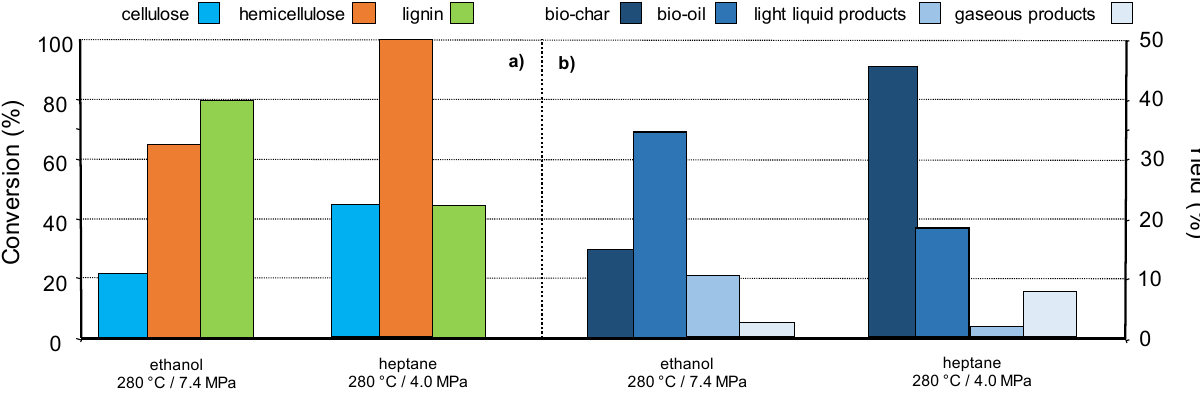
Figure 8. Pine wood ( a ) conversion and ( b ) products yields, in supercritical ethanol or supercritical heptane (solvent 27 g, wood 2.5 g, no catalyst, autogenous pressure, 1 h), in the absence of catalyst.